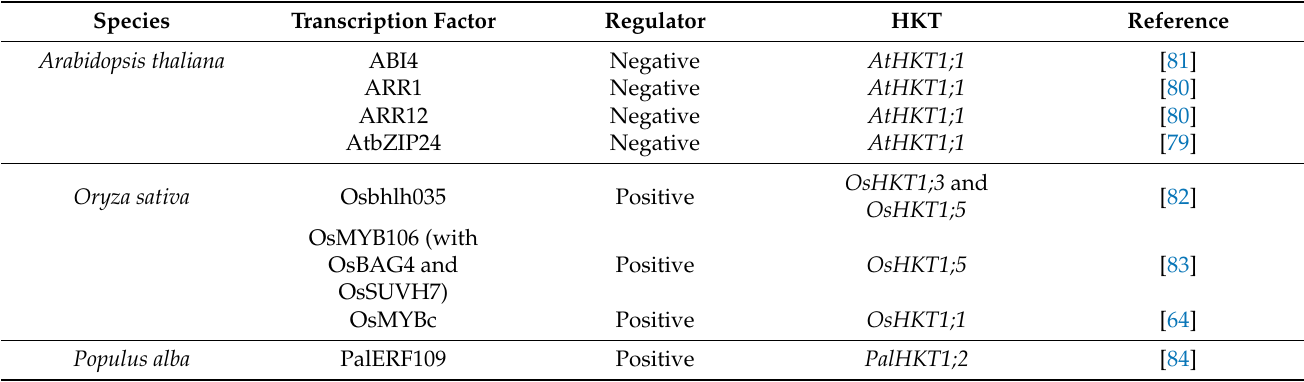
Table 2. Transcription factors that modulate HKT expression in